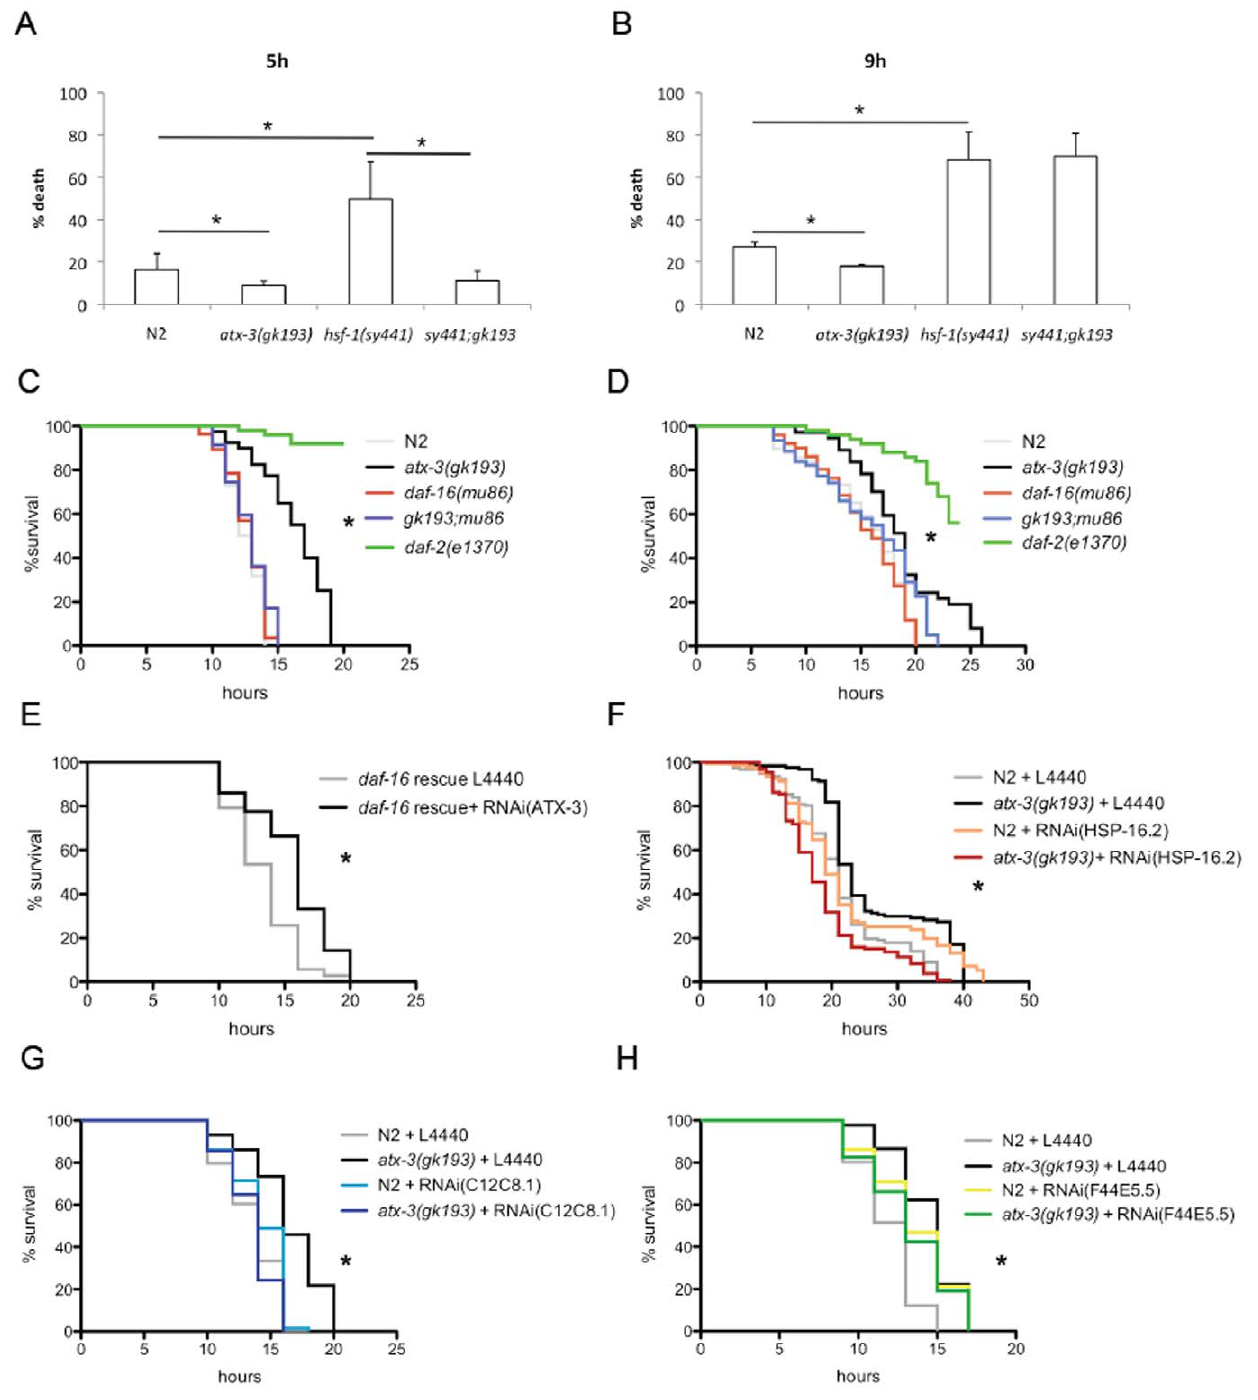
Figure 7. Atx-3 thermoresistance is dependent on DAF-16 transcription factor and independent on HSF-1. Wild type animals die more than atx-3 mutants after a 5 h ( A ) or 9 h ( B ) exposure to 35 u C heat shock. Hsf-1 animals have enhanced sensitivity to this temperature at both timepoints, as expected. Double atx-3; hsf-1 mutants still display enhanced thermoresistance at 5 h timepoint but behave as single hsf-1 mutants in the 9 h heat shock condition. Atx-3 mutants are more resistant to the exposure to a lethal heat shock at 35 u C than wild type animals, but daf-16 ; atx-3 double mutants are not, both when grown at 20 u C ( C ) or 25 u C ( D ). ( E ) Restoring DAF-16 levels in a daf-16 ; atx-3 ( daf-16 deletion and atx-3 knockdown; daf-16 rescue strain) background leads to the appearance of the thermotolerance phenotype. Increased thermotolerance of atx-3 mutants is still observed when grown on bacteria expressing RNAi empty vector (L4440) ( F ) and is dependent on hsp-16.2 ( G ), C12C8.1 ( H ) and F44E5.5 ( I ). Median survivals in animals grown in (C) are: N2: 12.5 h, atx-3 : 17 h, daf-16 : 13 h, daf-16 ; atx-3 : 13 h, daf-2 : not determined. Median survivals in (D) are: N2: 17 h, atx-3 : 19 h, daf-16 : 16 h, daf-16 ; atx-3 : 17 h, daf-2 : not determined. Median survivals in (E) are: daf-16 rescue in L4440: 14 h, daf-16 rescue in RNAi(ATX-3): 16 h. Median survivals in (F) are: N2 L4440: 21 h, atx-3 L4440: 23 h. N2 in RNAi(HSP-16.2): 19 h, atx-3 in RNAi(HSP- 16.2): 17 h. Median survivals in (G) are: N2 L4440: 14 h, atx-3 L4440: 16 h. N2 in RNAi(C12C8.1): 14 h, atx-3 in RNAi(C12C8.1): 14 h. Median survivals in (H) are: N2 L4440: 13 h, atx-3 L4440: 15 h. N2 in RNAi(F44E5.5): 13 h, atx-3 in RNAi(F44E5.5): 13 h. *p , 0.05. doi:10.1371/journal.pone.0018512.g007 PLoS ONE |